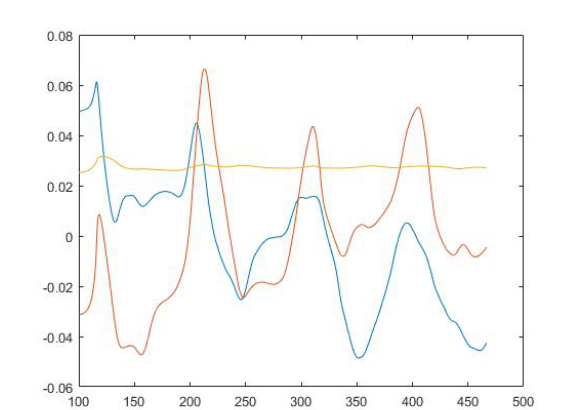
Fig. 28. The first three principal components for 100 cells in geometry